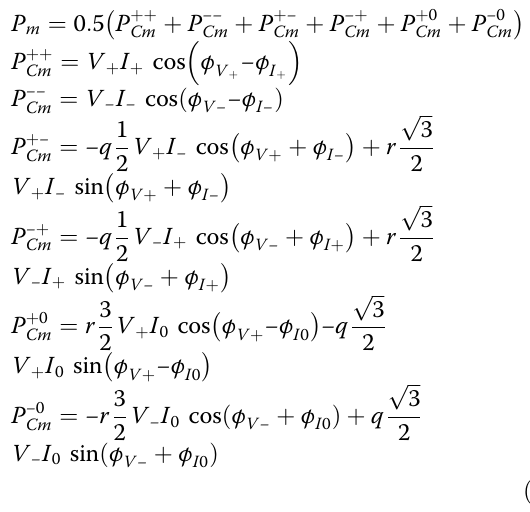
The inter-cluster DC capacitor voltage balancing control of the delta-connected MMCC sub-modules is the main focus of this paper. The inter-cluster power flow of the system is analyzed, while multiplying (1) and (2) gives the instantaneous and average power across each phase of the delta MMCC-STATCOM. The average cluster